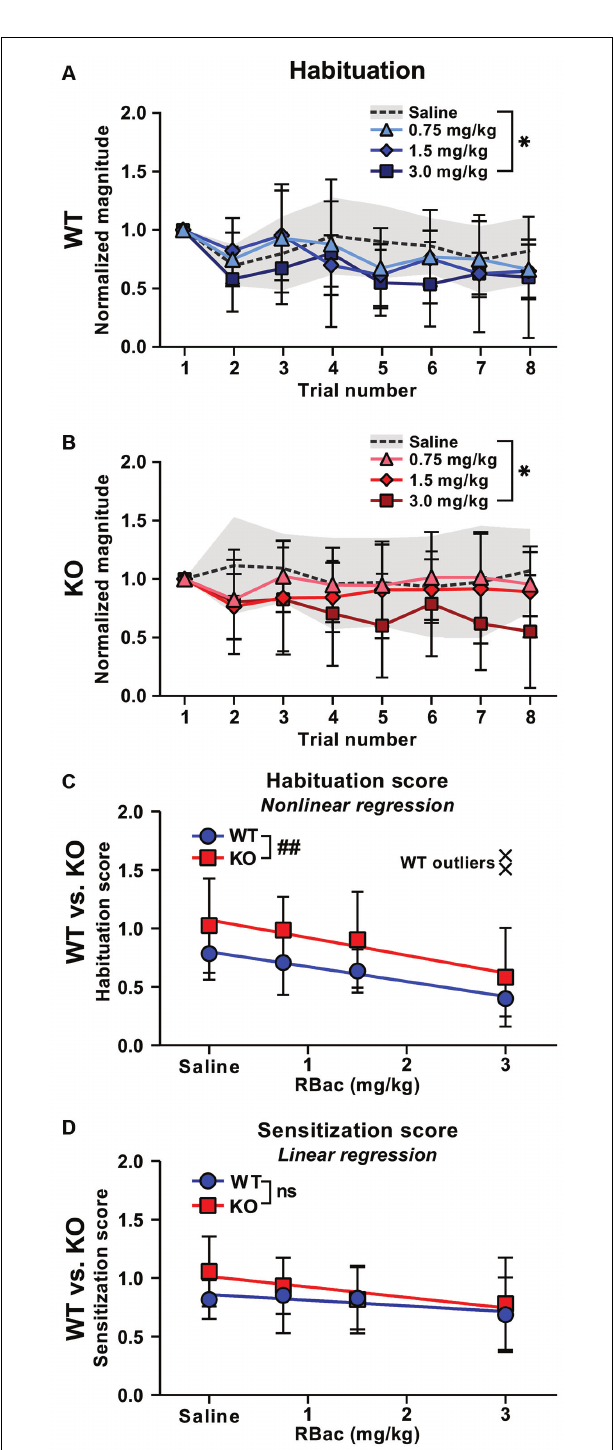
FIGURE 5 | Higher doses of R-Baclofen (RBac) normalize habituation in Cntnap2 KO rats. (A,B) Mean ± SD startle response magnitudes across eight subsequent trials normalized to the first trial in Cntnap2 WT ( A , blue symbols) and KO rats ( B , red symbols) 1 h after injection of 0.75 mg/kg (triangles and error bars), 1.5 mg/kg (diamonds and error bars), or 3.0 mg/kg (squares and error bars) R-Baclofen compared with vehicle (saline, dotted line and